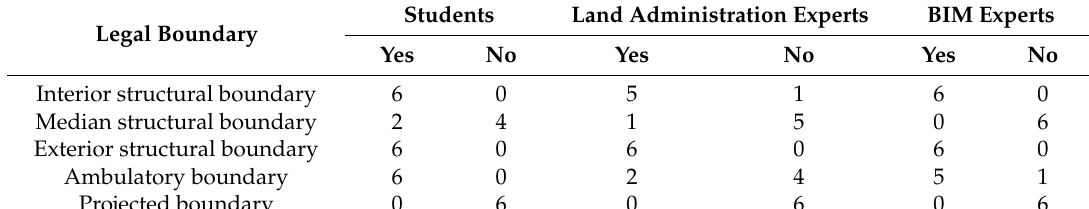
Table 4. Responses to visual understanding of legal boundaries in the purely physical model. Legal Boundary